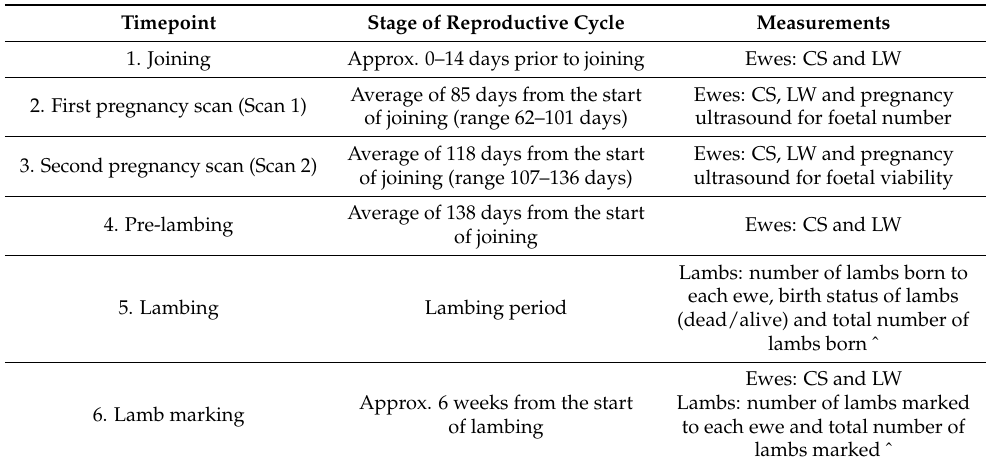
Table 1. Summary of timepoints, corresponding stage of the reproductive cycle and measurements performed throughout the study period for each